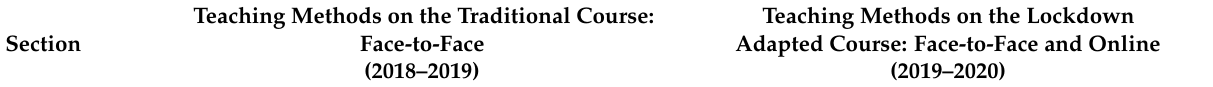
Table 1. Theoretical and practical teaching methods in cytology and histology: A description and comparison of teaching methods used prior to (traditional course) and during COVID-19 lockdown (lockdown-adapted